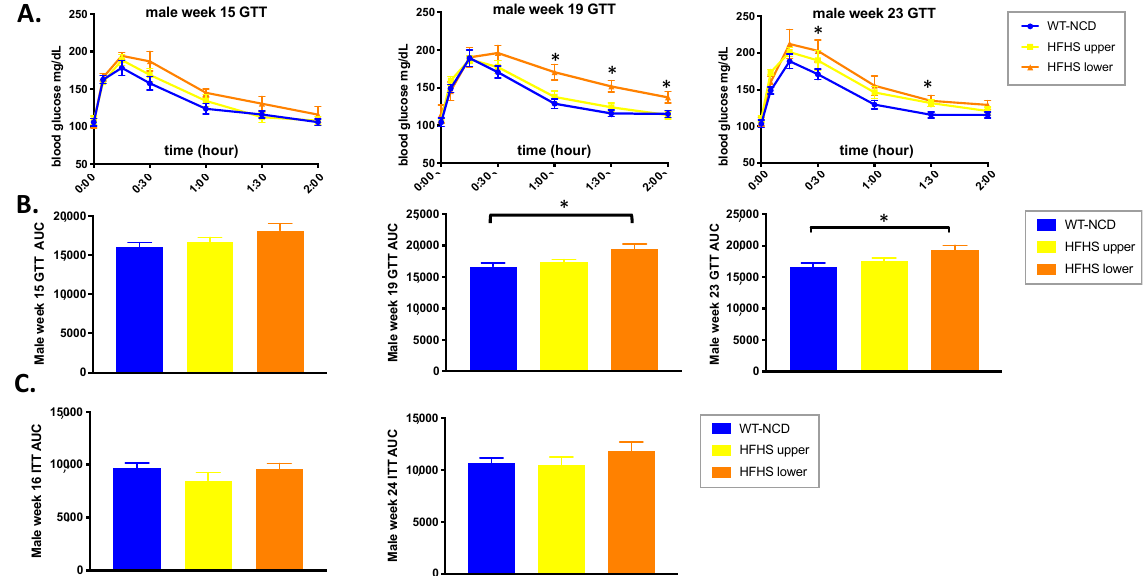
Figure 6. Gut microbial composition influences glucose response. ( A ) Week 15, 19 and 23 glucose tolerance test (GTT). ( B ) Area under the curve (AUC) of the GTT shown in ( A ) ( n = 8–14). ( C ) Week 16 and 24 insulin tolerance test (ITT) ( n = 10–13). ANOVA in JMP Pro version 14 was used to analyze significance with post hoc Dunnett’s analysis to determine significance with respect to the WT-NCD (* indicates p < 0.05).